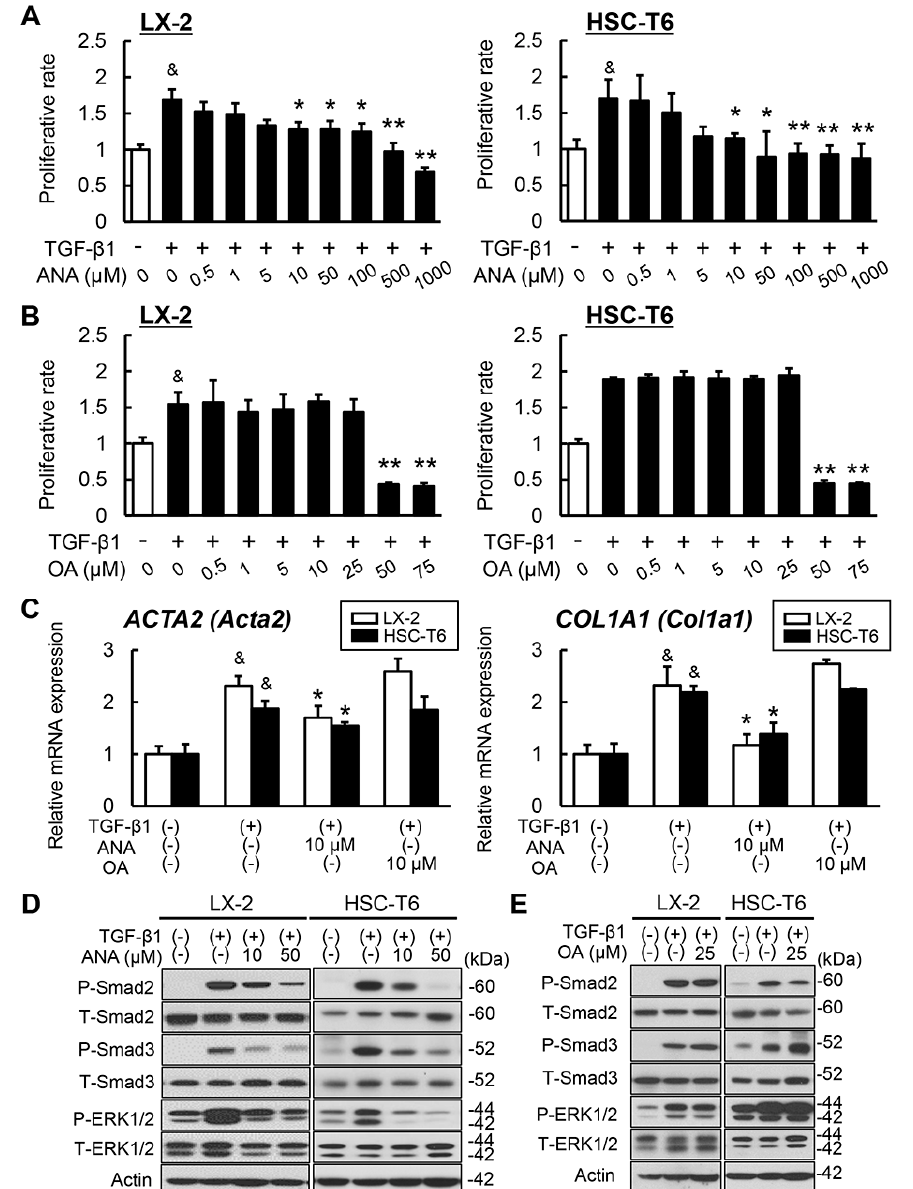
Figure 5. Effects of oleanolic acid and anagliptin in vitro hepatic stellate cells. ( A , B ) The effects of anagliptin (ANA) ( A ) or oleanolic acid (OA) ( B ) on the TGF- β 1-stimulated proliferation of LX-2 and HSC-T6 cells. Both cell lines were cultured with different concentrations of ANA or OA for 24 h. The proliferative rate is the ratio to control group cultured without TGF- β 1 and ANA or OA. ( C ) The effects of anagliptin (ANA) or oleanolic acid (OA) on the mRNA expressions of ACTA2 ( Acta2 ) and COL1A1 ( Col1a1 ) in the TGF- β -stimulated LX-2 and HSC-T6 cells. Both cell lines were cultured with 10 μ M of ANA or OA for 24 h. Quantitative values are relatively indicated as ratios to the values of ANA(–)/OA(–)-group. The mRNA expression levels were measured by quantitative RT-PCR (qRT- PCR), and Gapdh was used as internal control for qRT-PCR. ( D , E ) Western blots of whole cell lysates from LX-2 and HSC-T6 for the phosphorylation of Smad2, Smad3, and ERK1/2. The cells were cultured with and/or without TGF- β and ANA ( D ) or OA ( E ). Actin was used as internal control for western blotting. Data are mean ± SEM ( n = 8). & , P ≤ 0.01 compared with TGF- β 1(–)/ANA(–)/OA(–)- group; *, P ≤ 0.05; **, P ≤ 0.01 compared with TGF- β 1(+)/ANA(–)/OA(–)-group.